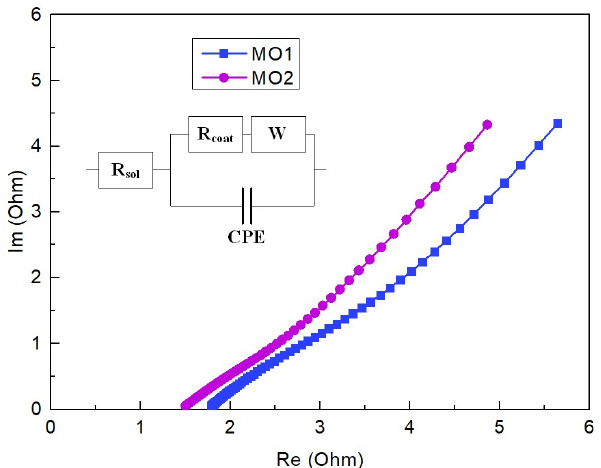
Figure 6. Electrochemical impedance spectra (EIS) of MO1 and MO2.